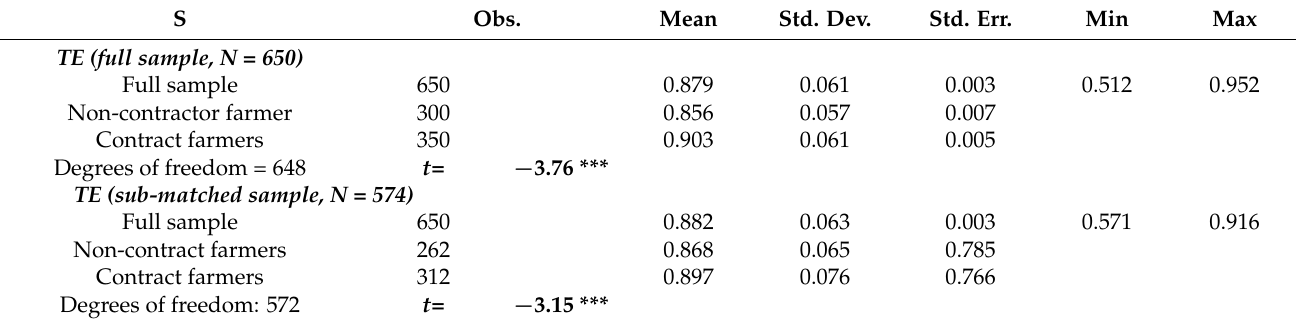
Table 5. Technical efficiency score for export-oriented rice production in Punjab,